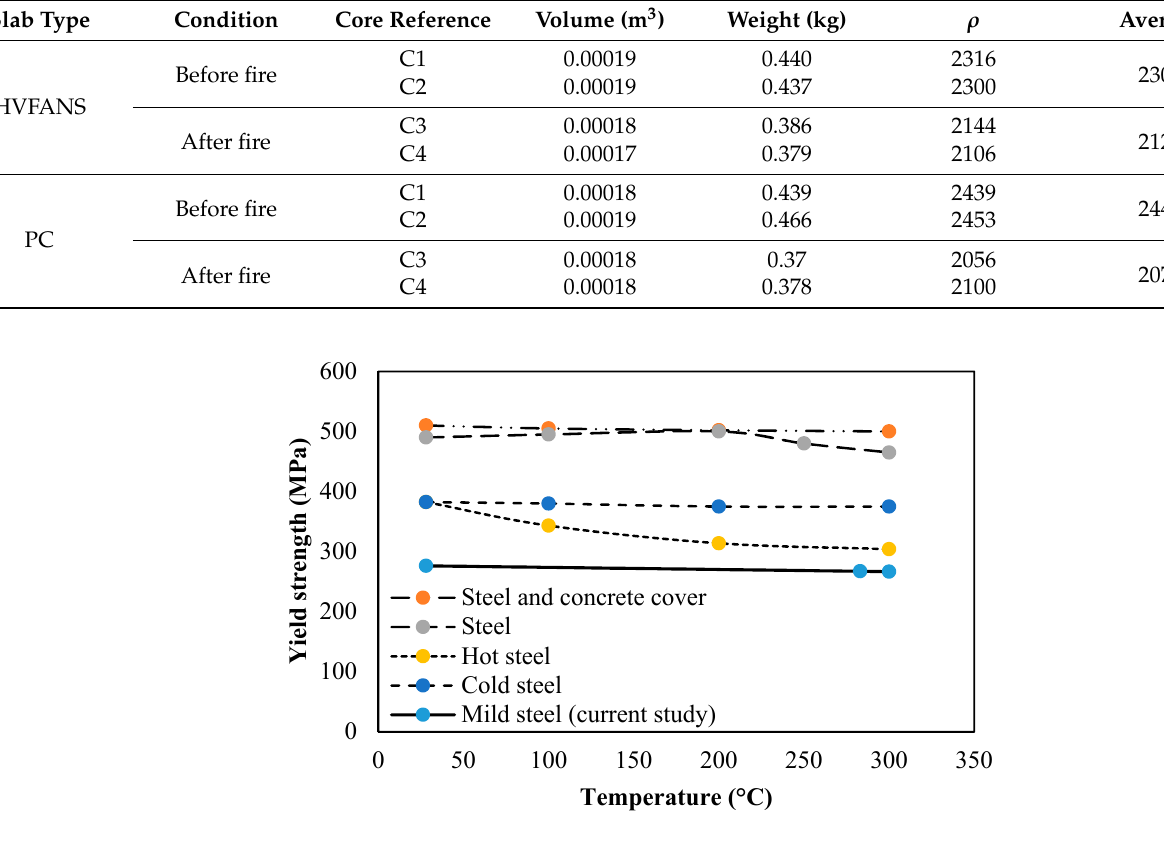
Figure 7. Yield strength of reinforcement at different temperatures [65,66].